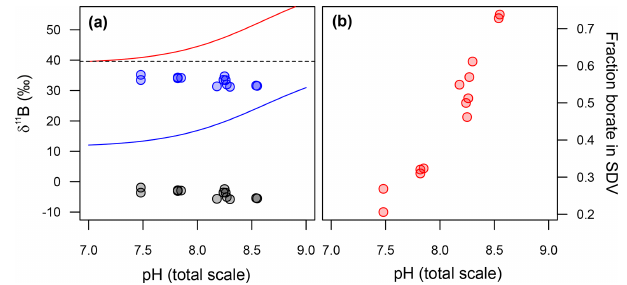
Figure 7. (a) Back-calculated δ 11 B of the silica deposition vesicle (SDV), and (b) the fraction of boron in the SDV that is derived from external borate. In (a) the diatom δ 11 B data are shown as grey circles and the calculated δ 11 B of the SDV as blue circles. Included in this model is an arbitrary − 10‰ fractionation between the δ 11 B of the SDV and the opal precipitated. The fraction of borate in the SDV in (b) is a function of this assumption, so these absolute values should be taken as illustrative